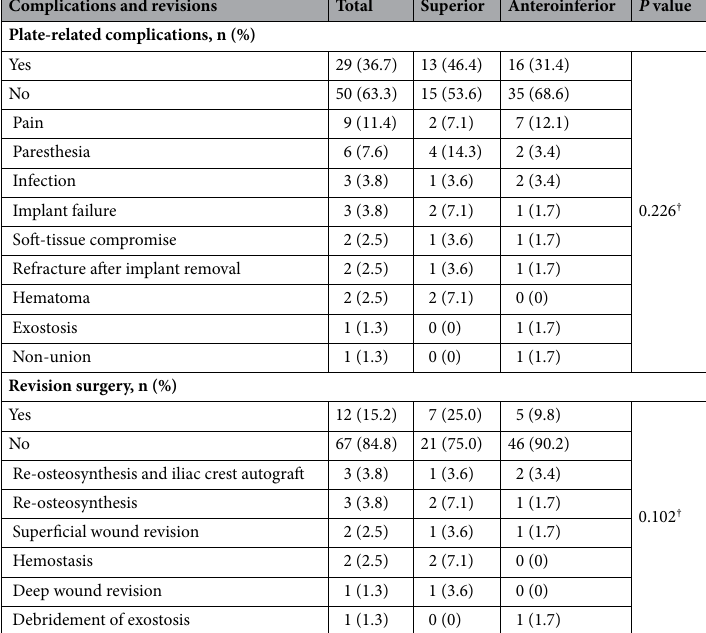
Table 6. Complications and revisions. † : Fisher exact